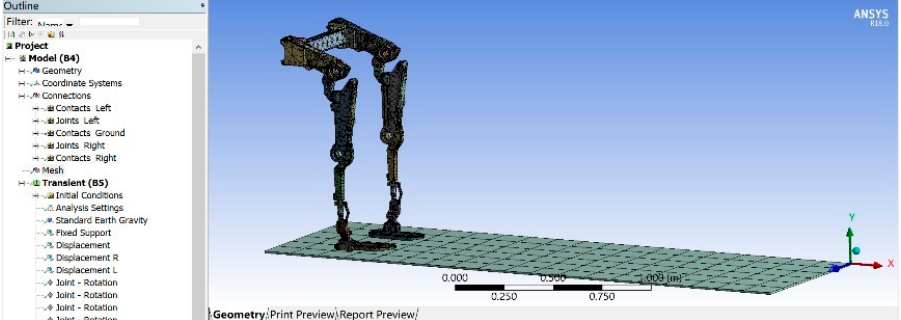
Figure 17. The setting of the ANSYS model.